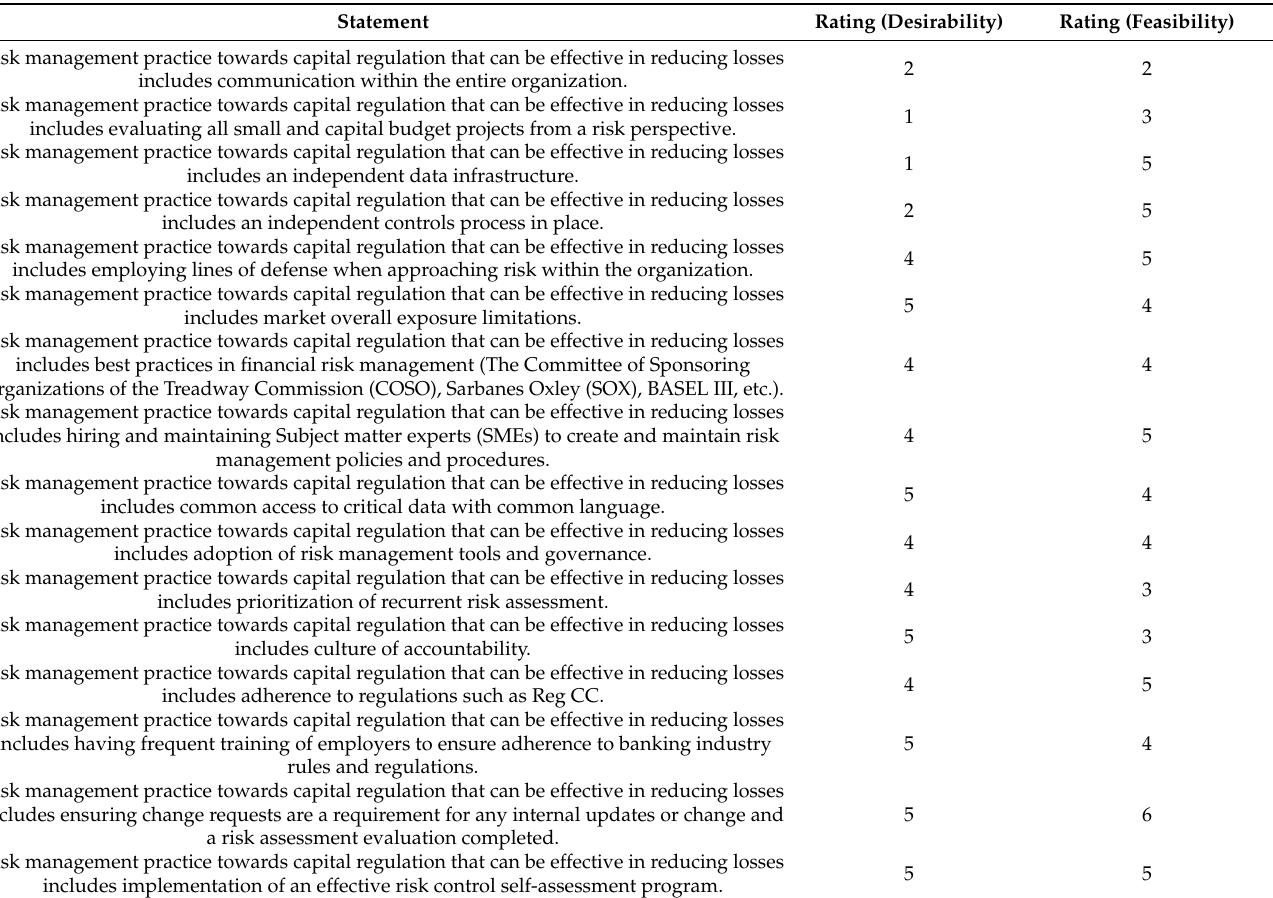
Table 2. Statements Failing to Meet Consensus Threshold in Round 2 and